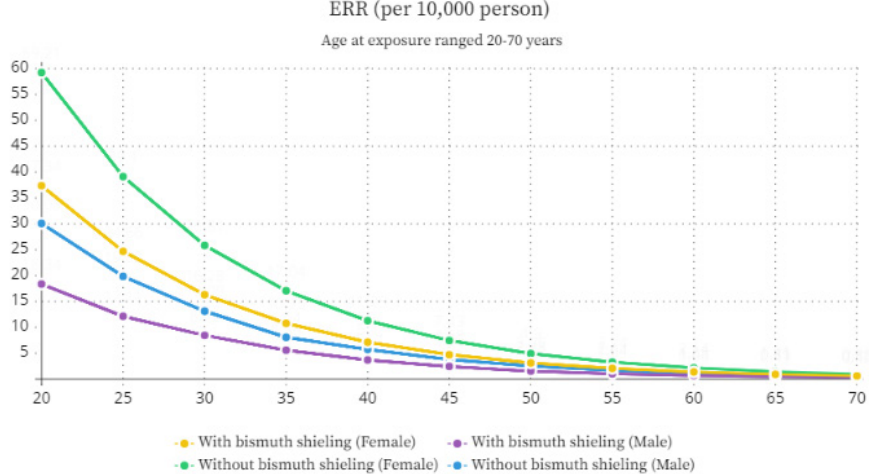
Figure 2 . ERR/mGy in 10000 Men and Women Using the Bismuth Shielding. Note . ERR: Excess relative